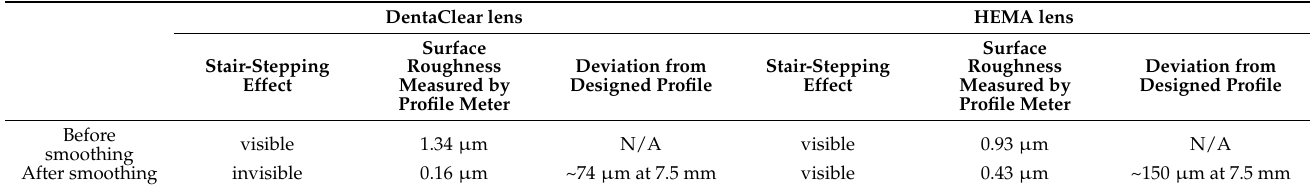
Table 1. Surface properties of the lenses without and after smoothing.